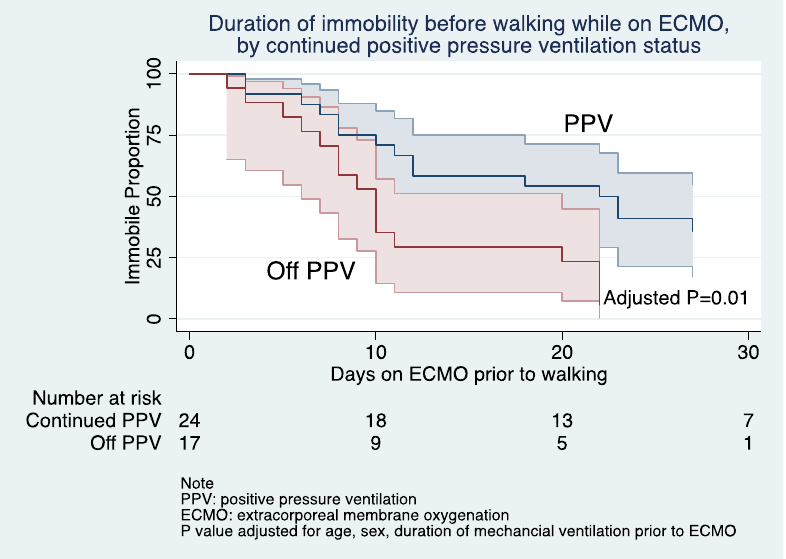
Figure 2. Proportion of patients over time remaining immobilized (not walking) on ECMO between groups; PPV (blue) and patients removed from PPV (red).